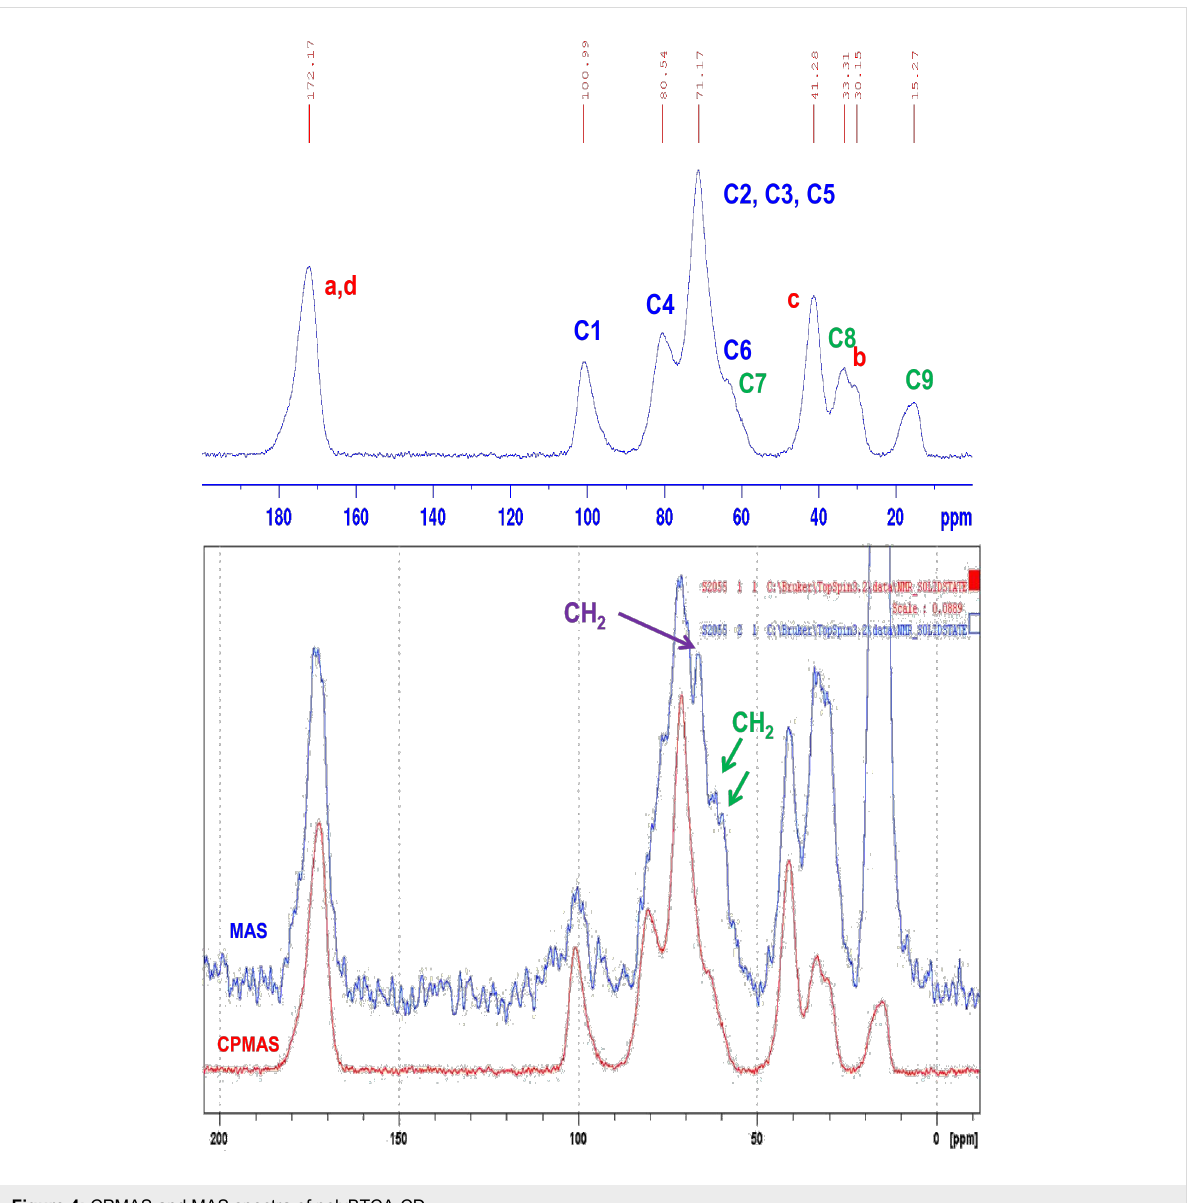
Figure 4: CPMAS and MAS spectra of polyBTCA-CD.